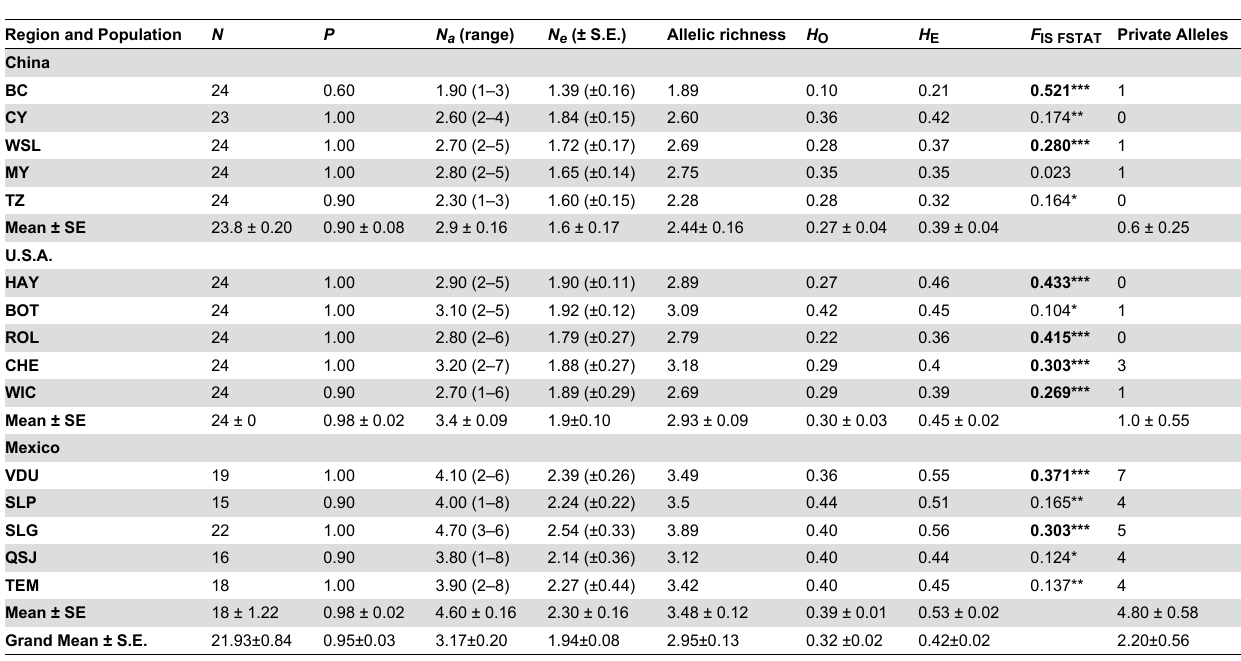
Table 2. Genetic diversity estimates for sampled population of Solanum rostratum in China, the U.S.A. and Mexico.